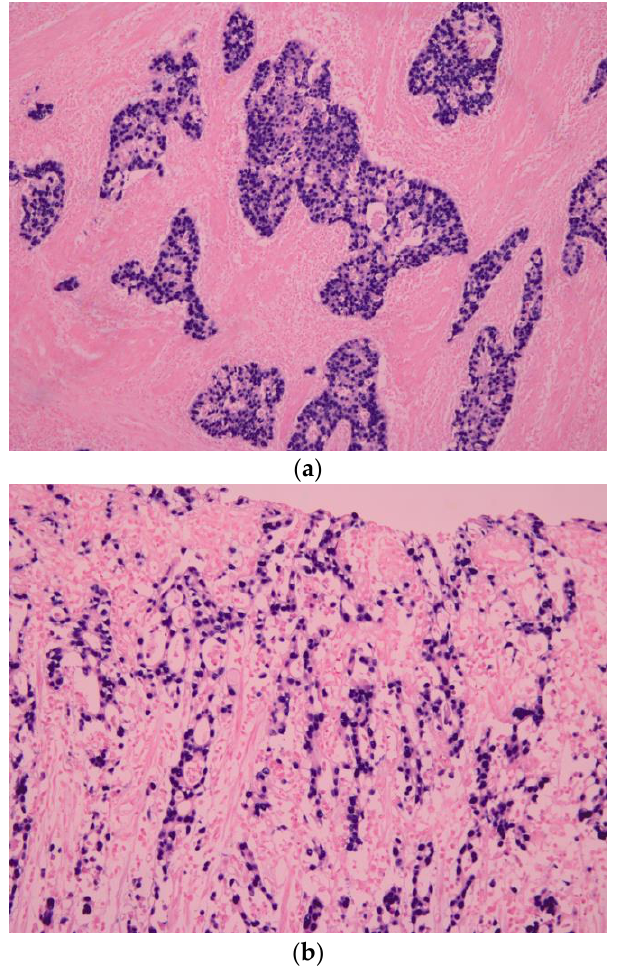
Figure 1. Histologic characteristic of Epstein–Barr virus-associated gastric carcinoma (EBVaGC). ( a ) EBV-encoded small ribonucleic acid (EBER1) in situ hybridization shows positive nuclei in the carcinoma cells, which are surrounded by infiltrating lymphocytes (×100); ( b ) Histologic characteristic of EBVaGC. The “lacy pattern” is composed of irregularly anastomosing tubules and moderate to dense lymphocytic infiltration (×100).